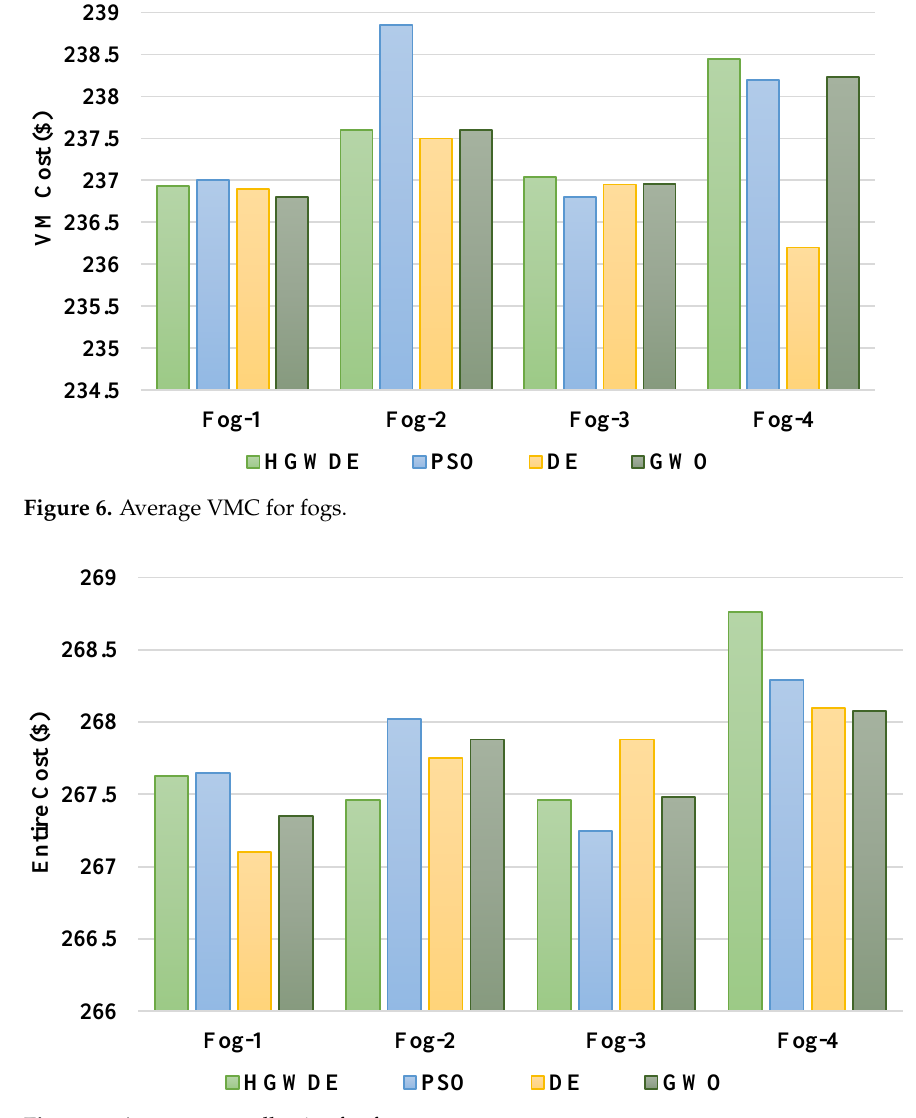
Figure 7. Average overall price for fogs.